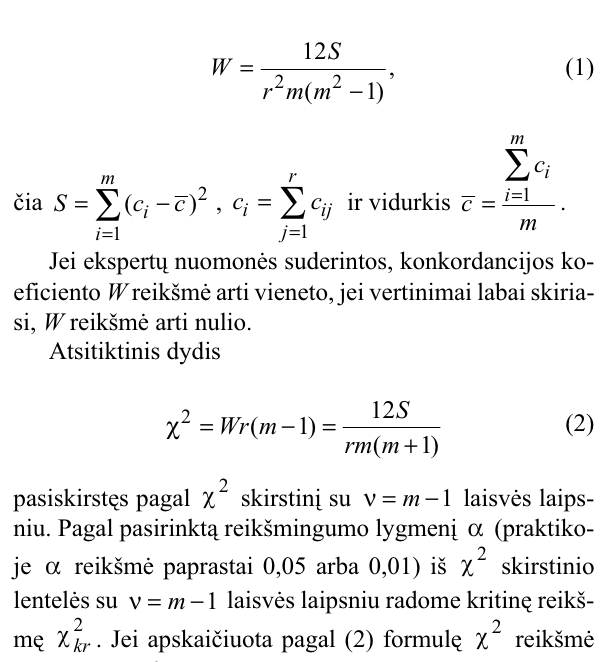
Table 2 . Experts’ assessments by 10-point grading system iatrepskE )iatsinabru(ėpurgųtrepske1 iatkejbO